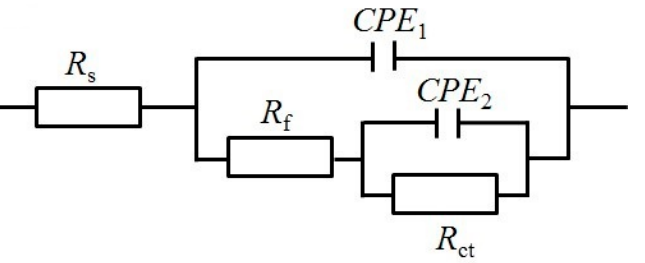
Figure 14. Equivalent circuit model used to fit EIS experiment data of carbon steel.